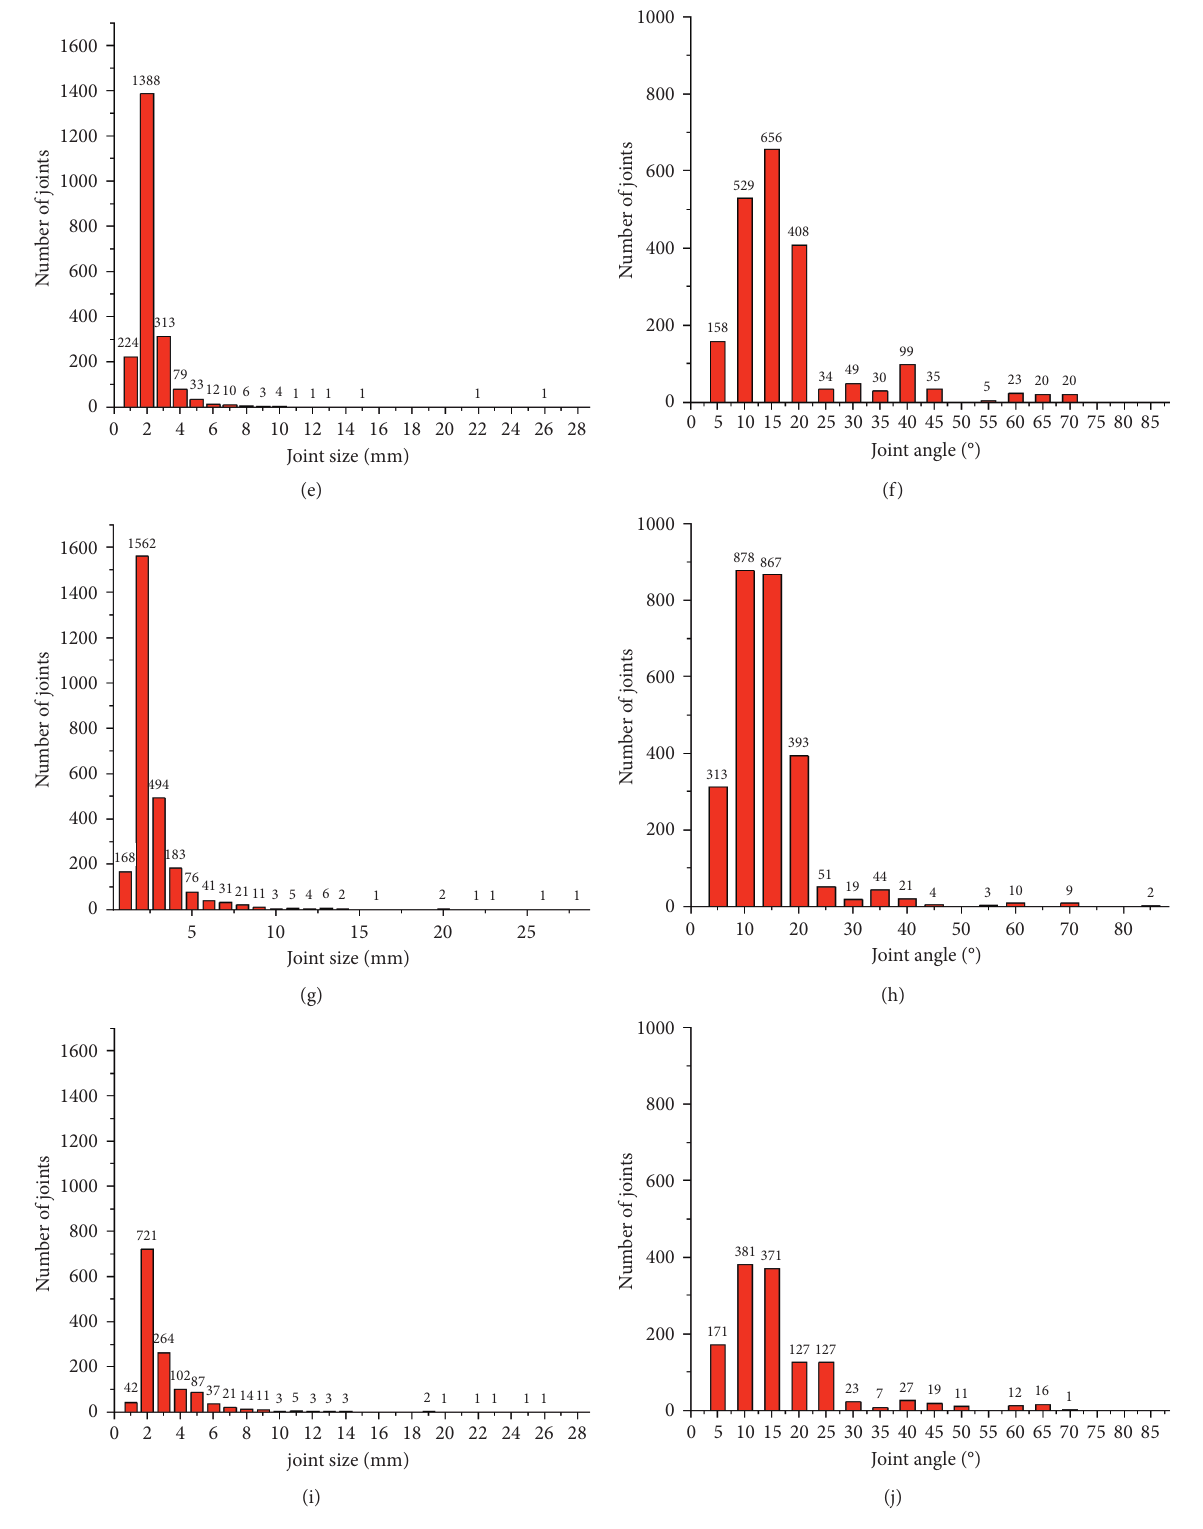
Figure 5: Statistics of nodal feature parameters. (a) Effective joint length statistics of coal sample 1. (b) Effective joint angle statistics of coal sample 1. (c) Effective joint length statistics of coal sample 2. (d) Effective joint angle statistics of coal sample 2. (e) Effective joint length statistics of coal sample 3. (f) Effective joint angle statistics of coal sample 3. (g) Effective joint length statistics of coal sample 4. (h) Effective joint angle statistics of coal sample 4. (i) Effective joint length statistics of coal sample 5. (j) Effective joint angle statistics of coal sample